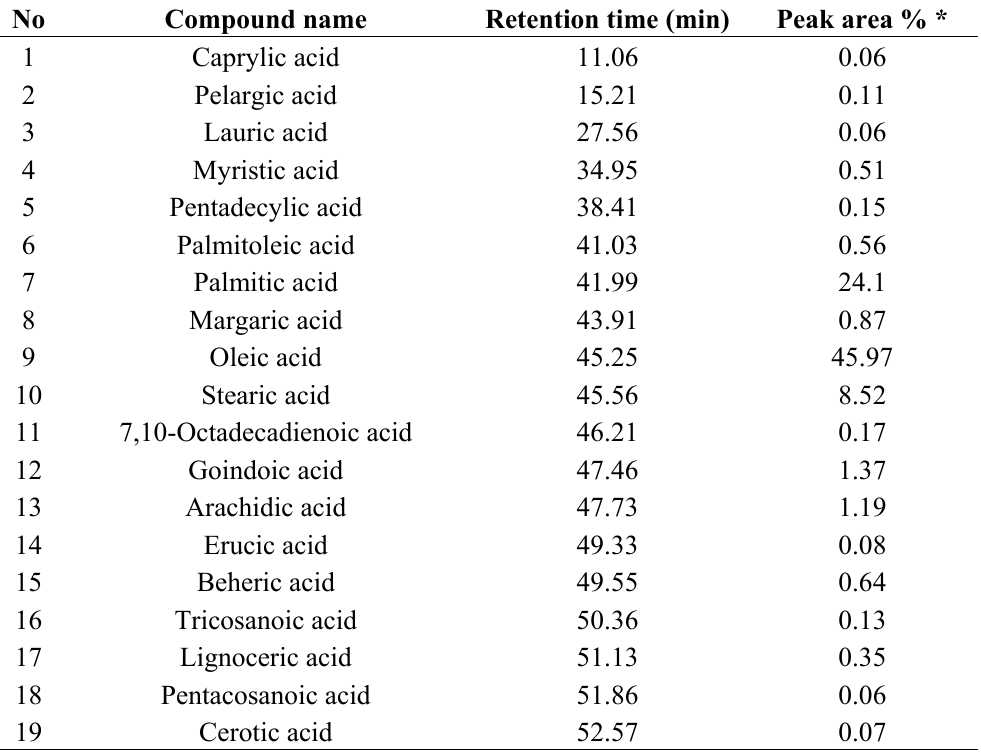
Table 1. Fatty acids of the chloroform extract of C. papaya.